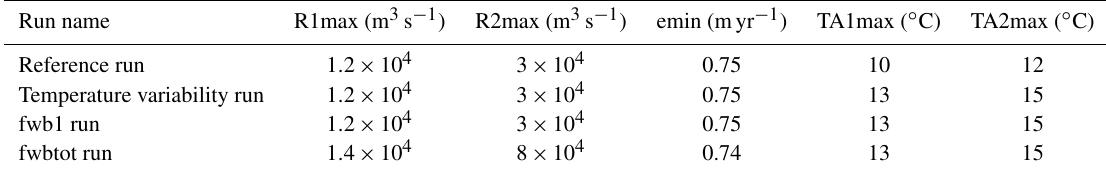
Table 3. Forcing parameters that vary between